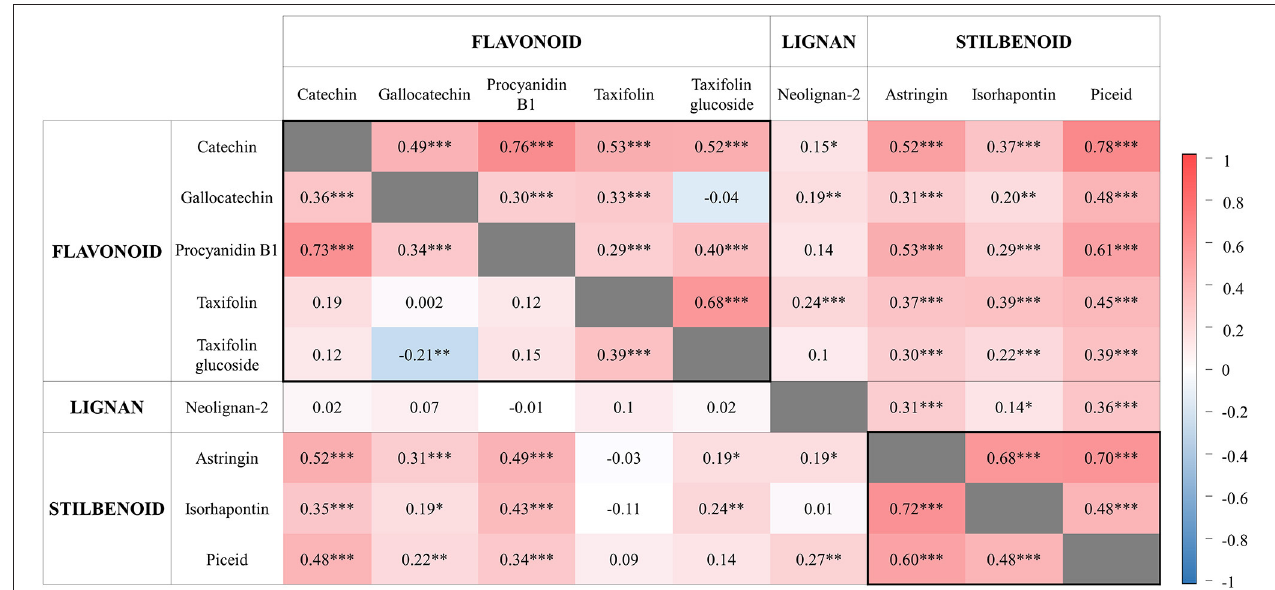
FIGURE 3 | Pairwise correlations between phenolic compounds contents measured in 2014 (bottom left; 164 siblings) and 2017 (top right; 202 siblings). Metabolites are classified into three major classes. The scale bar reports positive (red) and negative (blue) correlations. For each phenotypic correlation, the correlation coefficient and significance level are indicated. Levels of significance are as follows: * P < 0.05, ** P < 0.01, and *** P < 0.001.